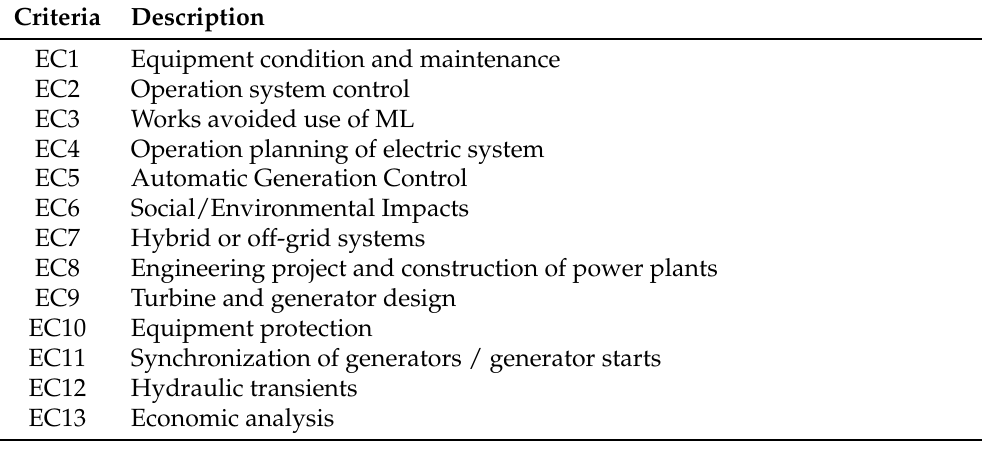
Table 3. Exclusion criteria.